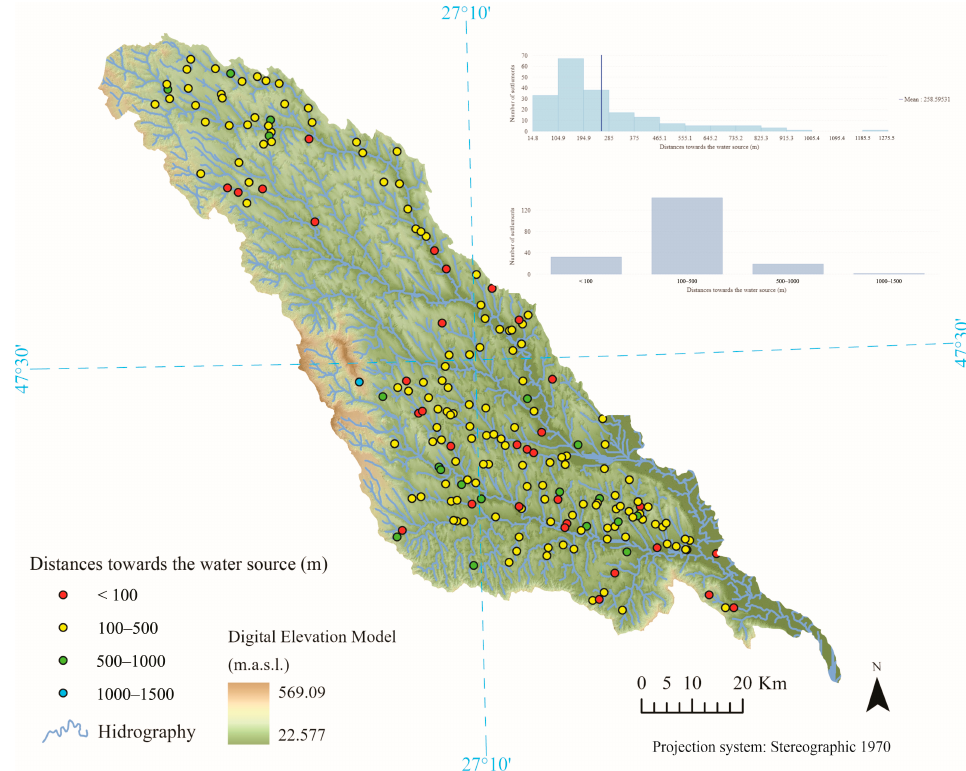
Figure 9. Noua settlements with ashmounds classified according to the distance towards the nearest water source, with graphs showing the values obtained for all the sites and their distribution within the main categories.